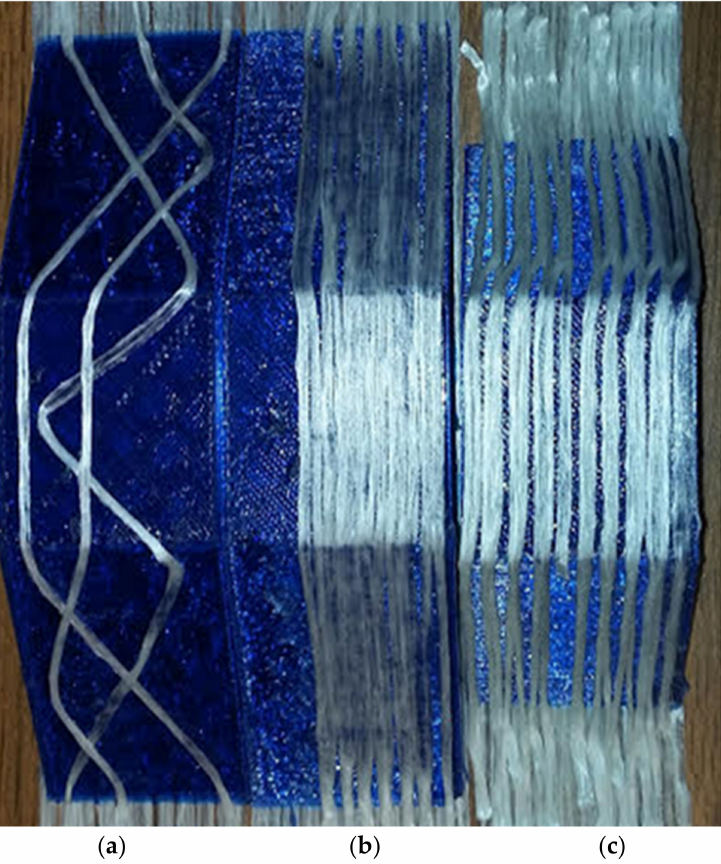
Figure 11. ( a ) Non-linear, ( b ) linear paths on 30 ◦ , and ( c ) 45 ◦ trapezoidal tool sloped